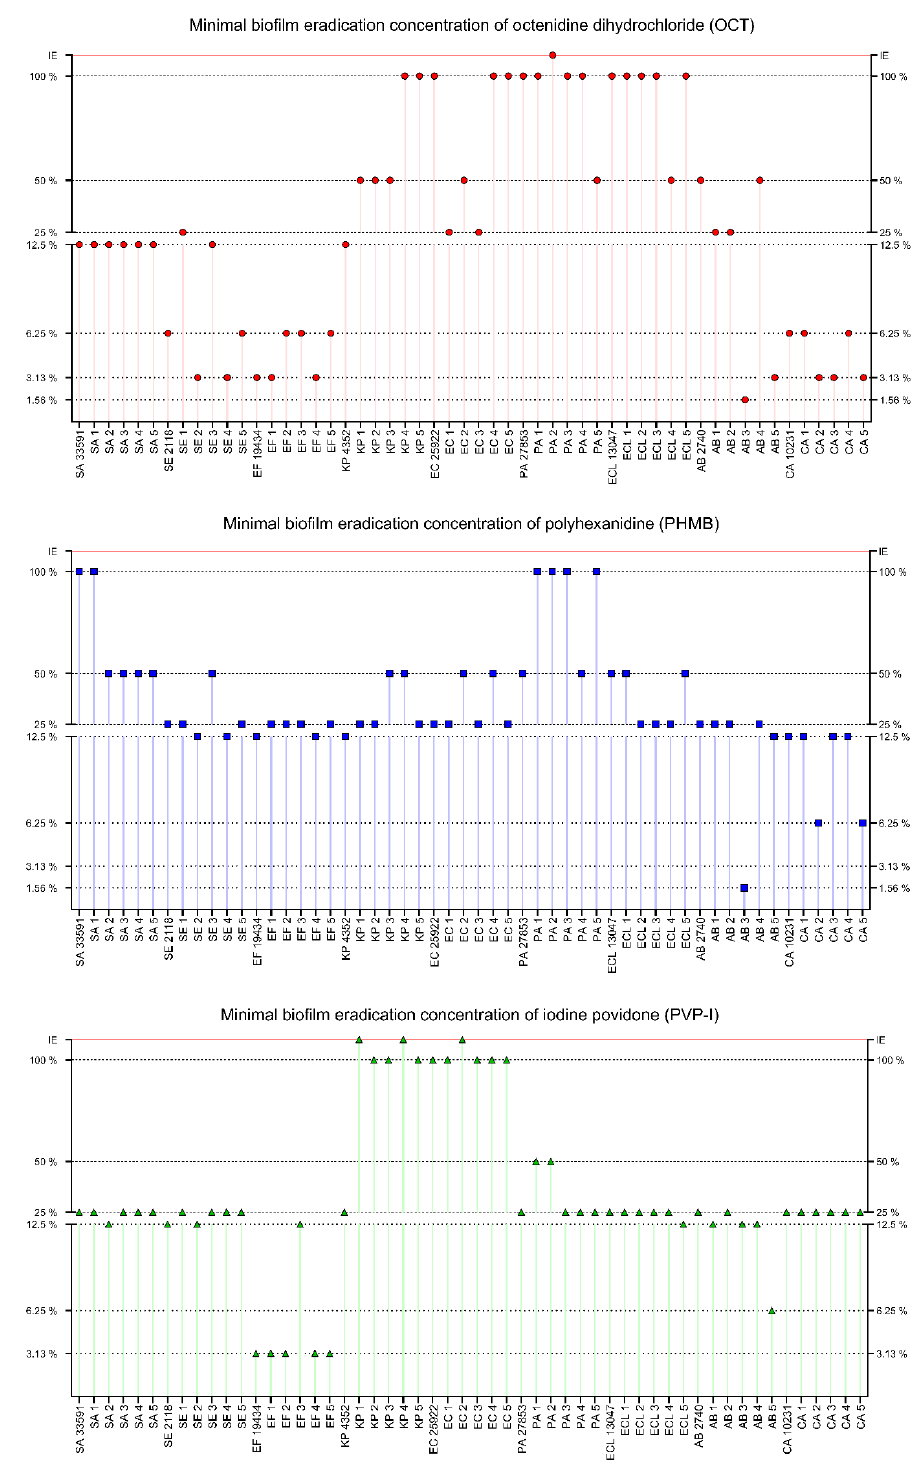
Figure 8. Minimal biofilm eradication concentrations of OCT, PHMB and PVP-I, presented as a percentage of working solutions (concentration provided by the manufacturer). Tested compounds: OCT — octenidine dihydrochloride, PHMB — polyhexanide, PVP-I — povidone-iodine (Octenilin ® 0.05% of OCT, Prontosan ® 0.1% of PHMB and Braunol ® 7.5% of PVP- I). Tested strains: SA — Staphylococcus aureus , SE — Staphylococcus epidermidis , EF — Enterococcus faecium , KP — Klebsiella pneu- moniae , EC — Escherichia coli , PA — Pseudomonas aeruginosa , ECL — Enterobacter cloacae , AB — Acinetobacter baumannii , CA — Candida albicans . IE — compound was ineffective.